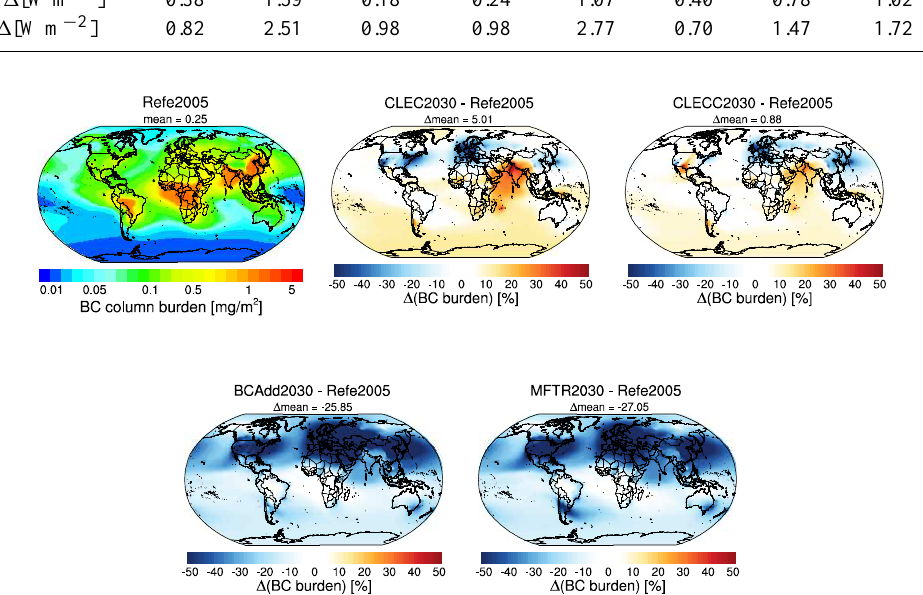
Figure 2. The annual mean black carbon (BC) burden in the reference run and the relative differences between the scenarios and the reference